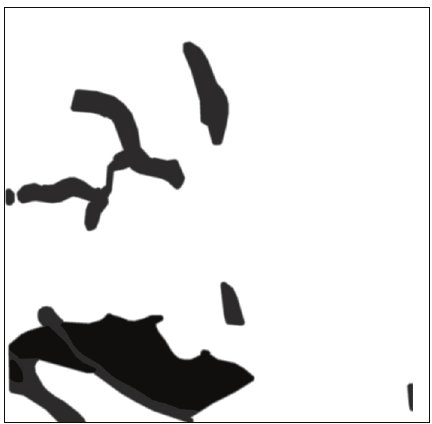
Figure 3: Visualization of calculation results of coefficient 𝐶 2 .